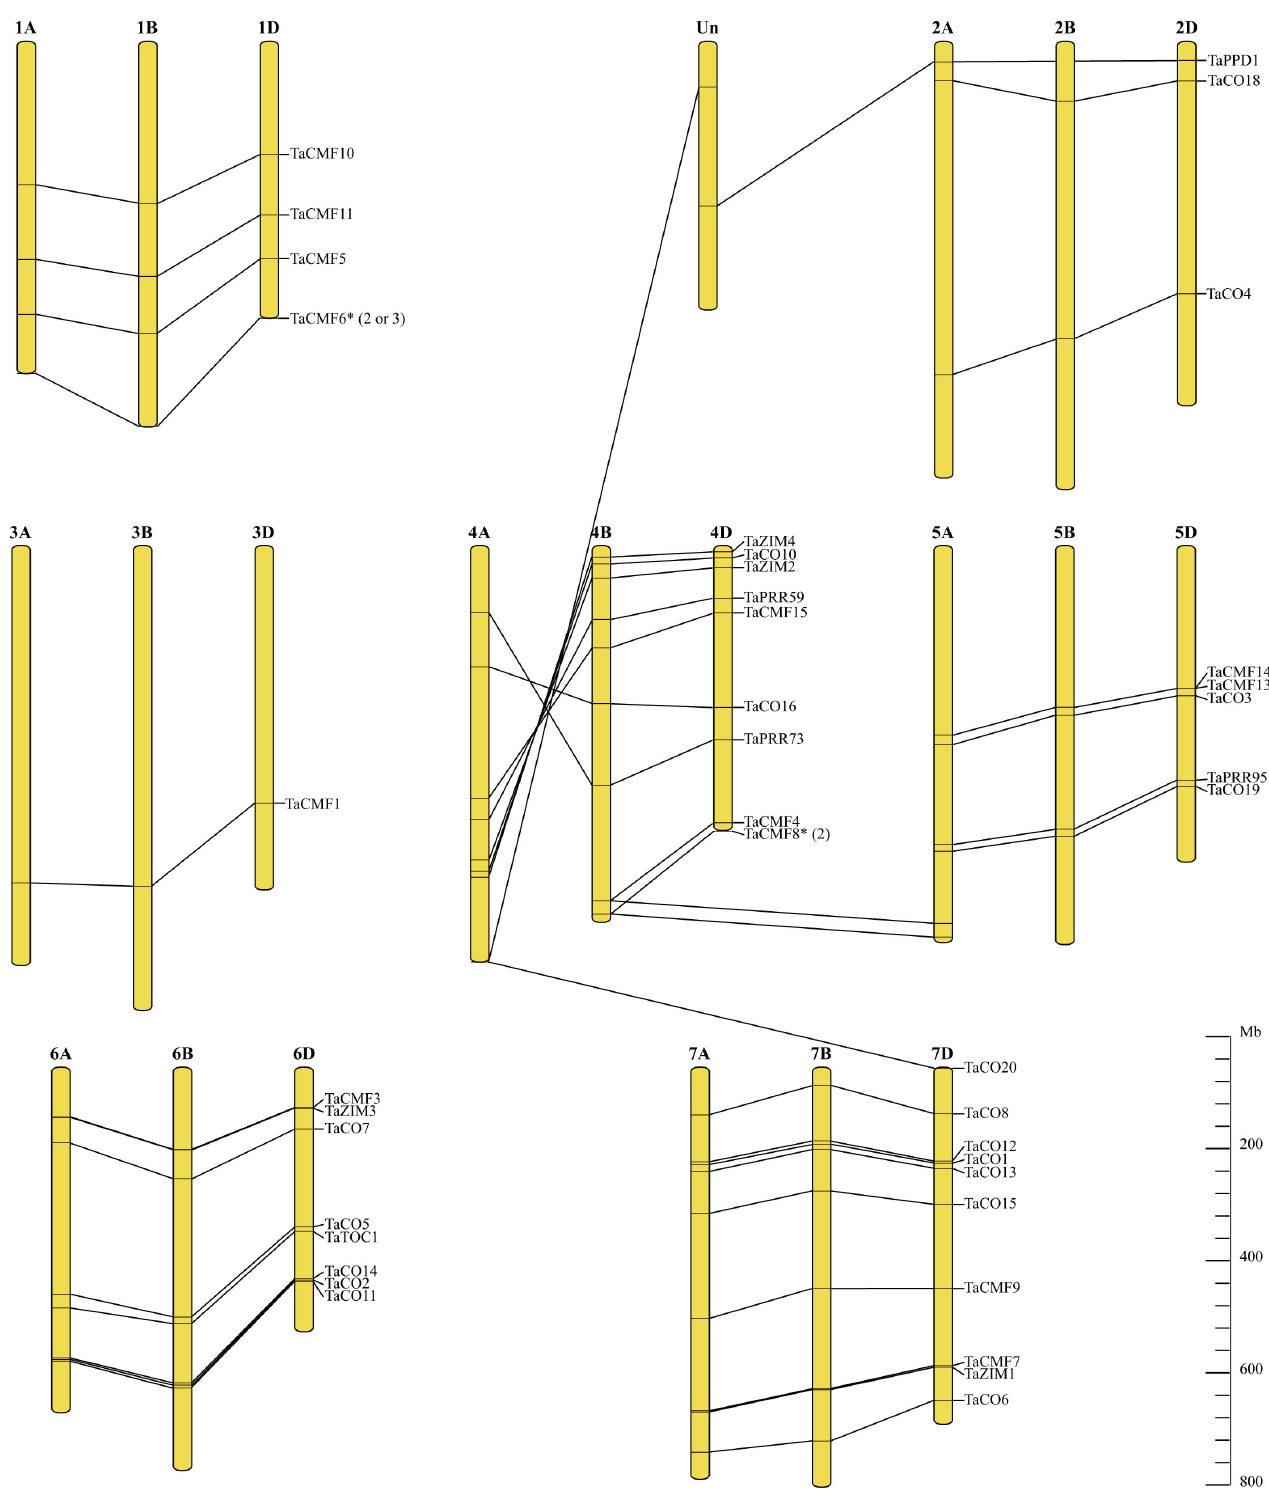
Fig 4. Chromosomal localization of CCT genes in wheat visualized by TBtools. Gene clusters with at least three genes distributed among the three subgenomes are marked on the right. Asterisks indicate the clusters with tandemly arranged genes, and the copy number in each subgenome is shown in